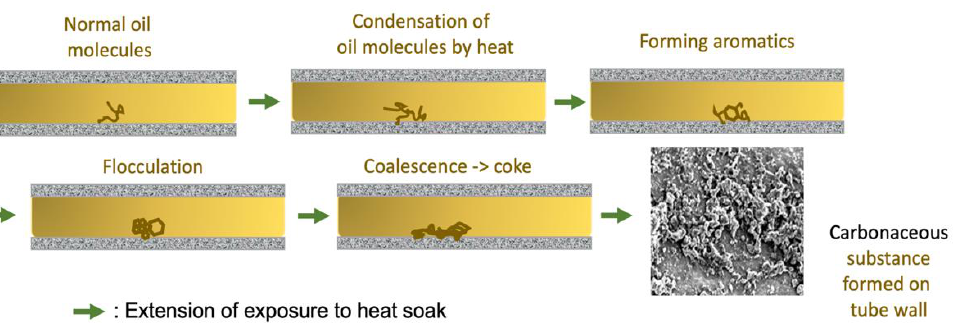
Figure 4. Schematic illustration of coke formation from thermal reactions of lubricant oil staying still in a metal tube in heat soak, where flocculation leads to fusion of organic aromatic flocs. The inset shows the deposition and growth of carbonaceous crumbs on the interior wall of SS-321 tubing.